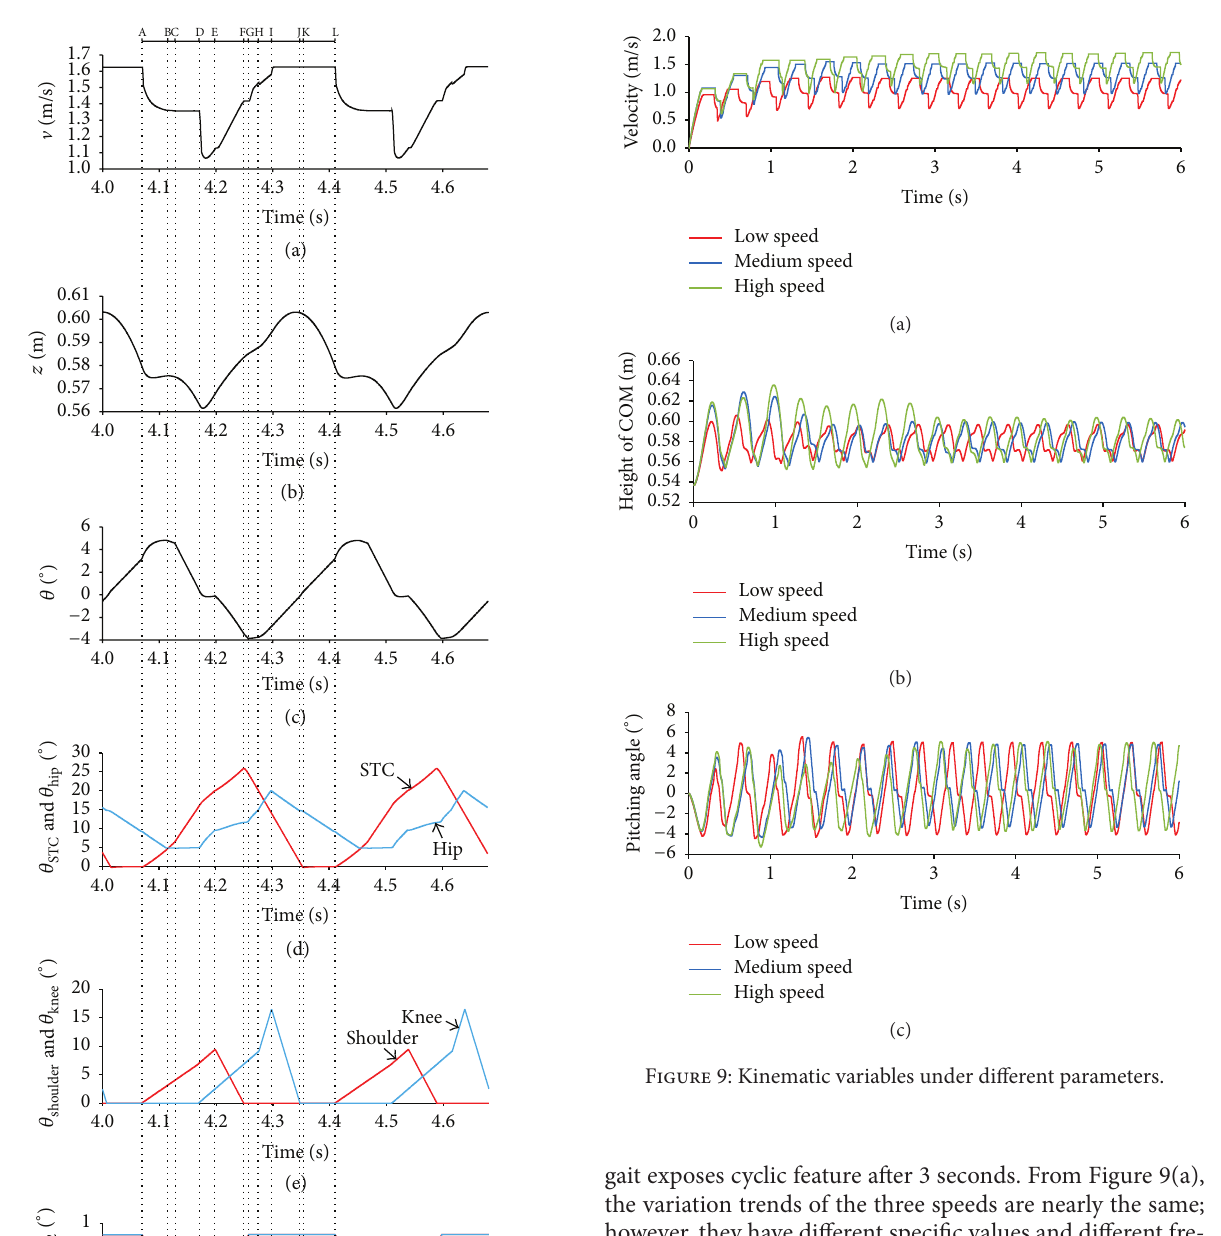
gait exposes cyclic feature after 3 seconds. From Figure 9(a), the variation trends of the three speeds are nearly the same; however, they have different specific values and different fre- quencies. The low, medium, and high speeds are approximate average 1.05, 1.33, and 1.53 m/s, respectively, during the steady cyclic state. In addition, there are 16, 17, and 18 complete strides under the low, medium, and high speed, respectively. The proportion coefficients 𝛼 𝑗 between the torque and the velocity difference (Equation (4)) should be increased for increasing the forward velocity during stance phase (Table 5). In addition, 𝑇 𝑗 also shows an increasing tendency and forms an increasing resultant torque of the STC combined with the increasing 𝛼 𝑗 . Meanwhile, the leg motion should be planned again to compensate the unstable pitching motion along with the increased forward velocity. The extending angular velocity of shoulder and elbow exposes a decreasing tendency for increasing the forward speed. On the contrary, the extending angular velocity of the knee and ankle shows an increasing tendency for increasing the forward